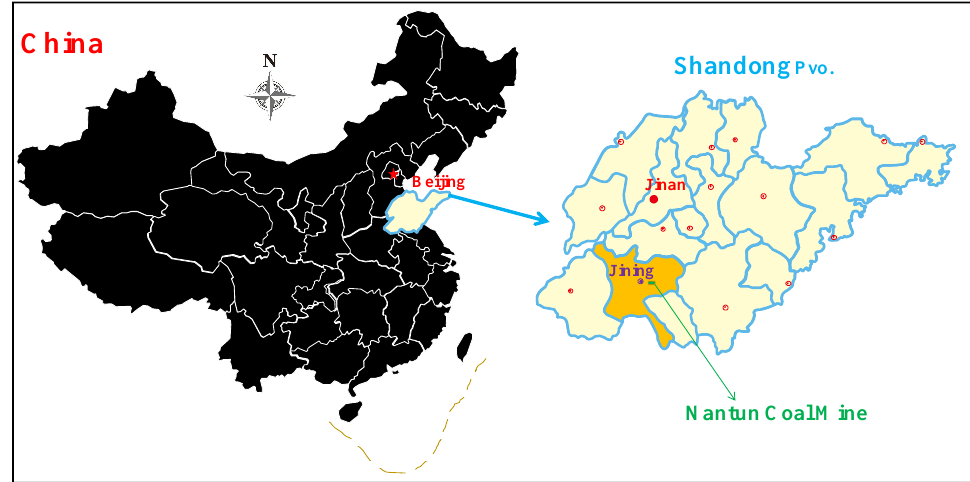
Figure 1. Geographical location of the Nantun Coal Mine.